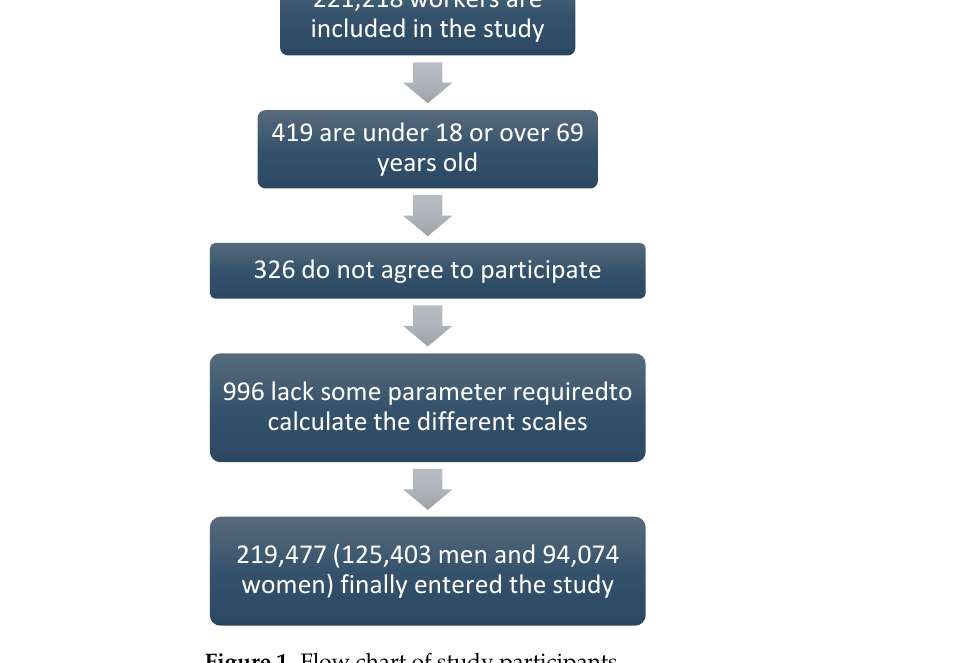
Figure 1. Flow chart of study participants.